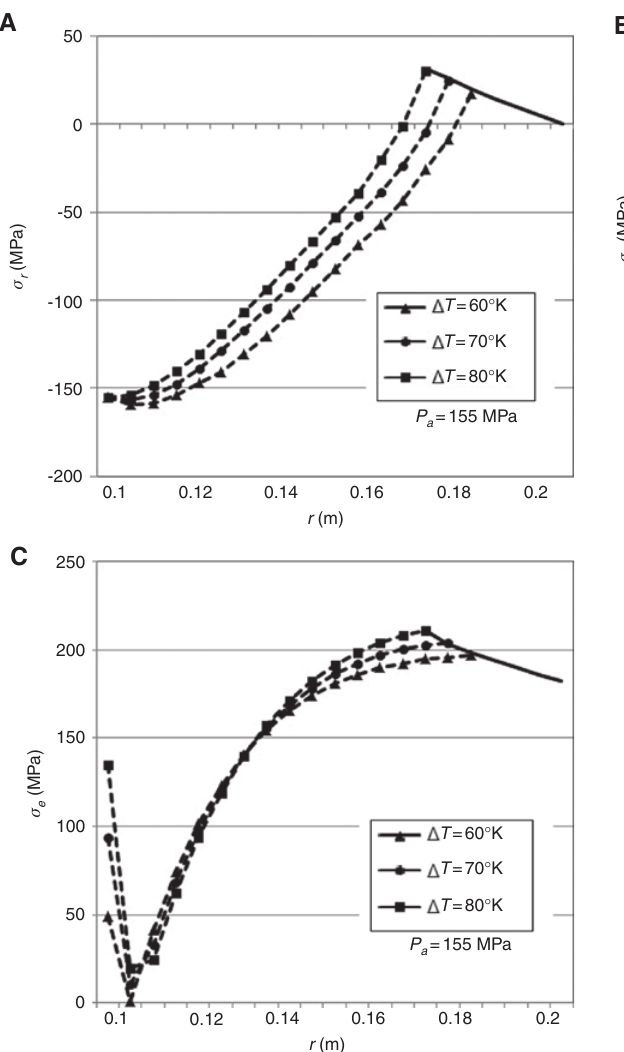
Figure 8: Elasto-plastic (A) radial, (B) circumferential and (C) effective stresses in an FG cylinder subjected to combined pressure and